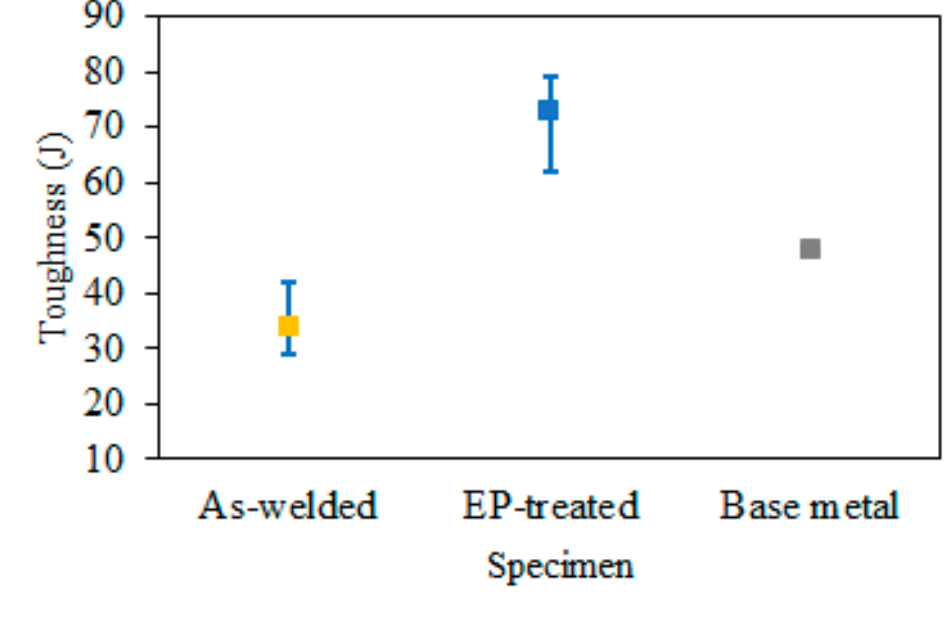
Figure 10. Evolution of Impact toughness. sented in Figure 11. Figure 11a exhibits two different morphologies: dimple of the weld-bead region and cleavage facet of the as-welded HAZ region. According to the Griffith theory [23], the cleavage fracture stress can be estimated by σ c ∝ d − 1/2 . Here, d can be regarded as the maximum diameter of the coarse grain, which was measured to be 20.35 µ